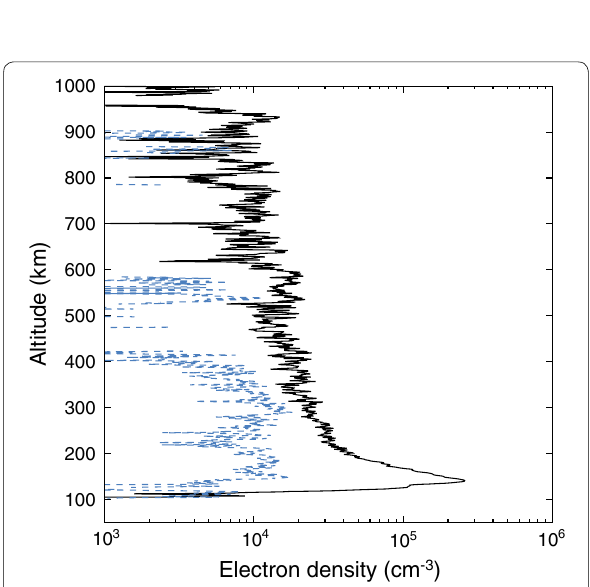
Fig. 9 Electron density profile obtained from the ingress occultation (solid) that sampled an illuminate region (SZA 78°) and the profile = from the egress occultation (blue dashed) that sampled an unillumi‑ nated region (SZA 102°) conducted on May 6, =